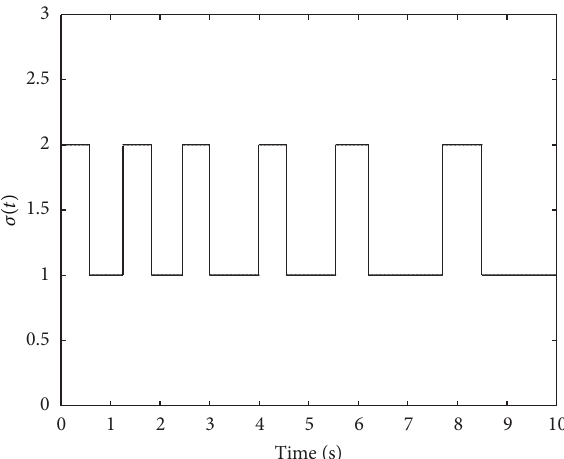
Figure 6: The switching signal 𝜎(𝑡) of the switched delay network (69) with average dwell